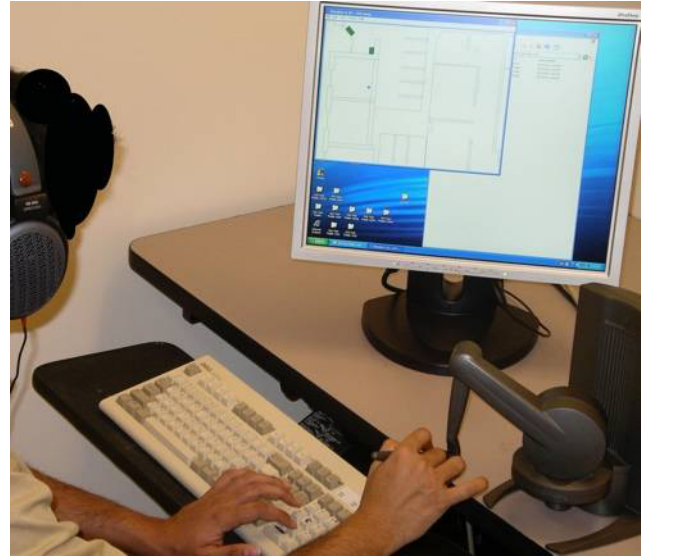
Figure 3. BlindAid